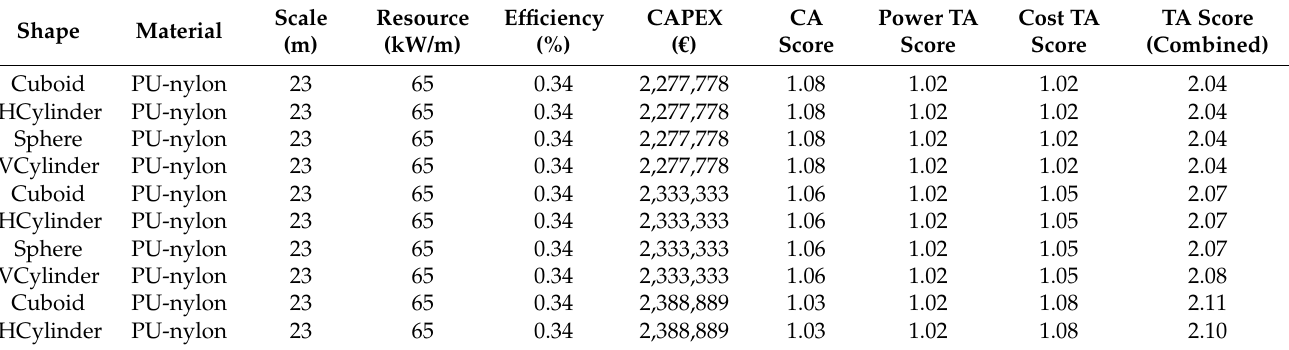
Table 10. The Top 10 in order of CA score, filtered for ‘attractive and